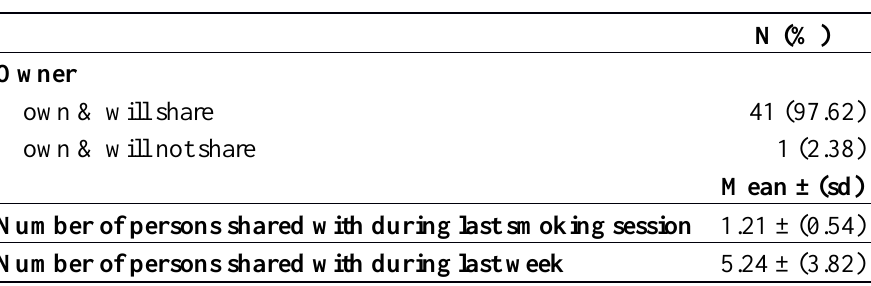
Table 3. Waterpipe Sharing